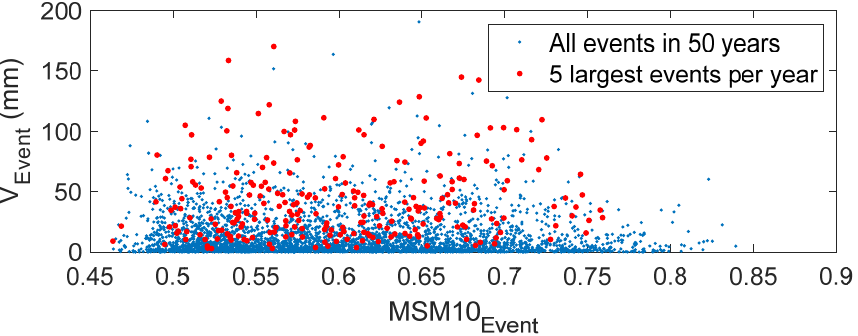
Figure 5. Comparison of the initial soil moisture value associated to each rainfall event (MSM10Event) and the total depth associated to the rainfall event (VEvent) during the 50 years of continuous simulation for: all the rainfall events (blue dots) and the five biggest total depth events per year (red dots).